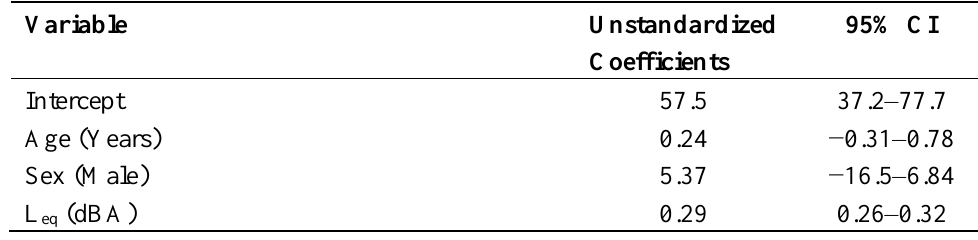
Table 4. Mixed effect linear regression model of the mean of heart rate (bpm) for a 3.75 minute interval.